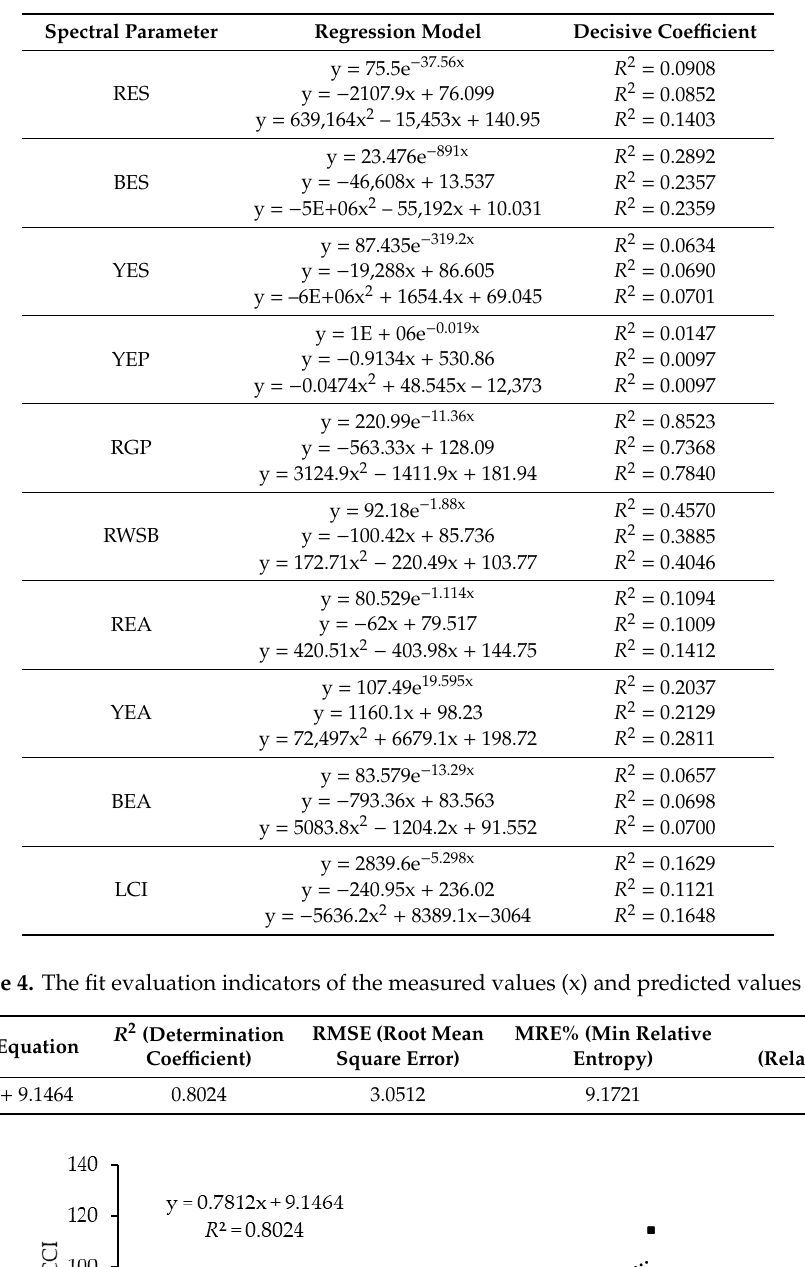
Table 3. Regression model of chlorophyll content and spectral parameters (sample number = 60).